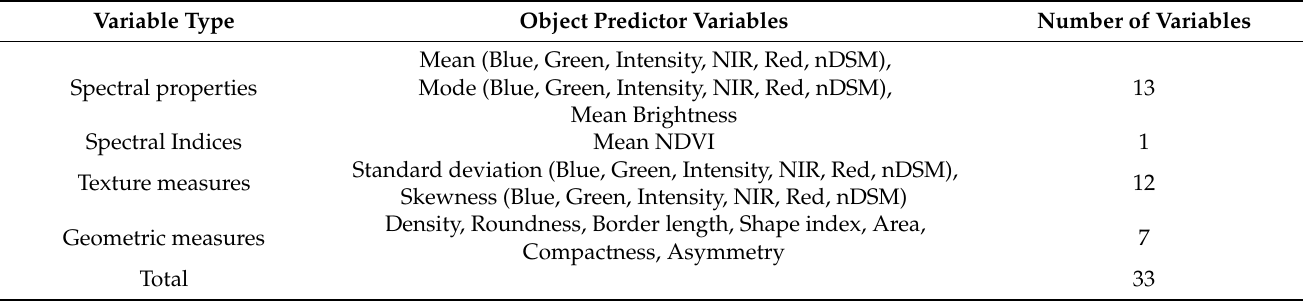
Table 2. Image-object predictor variables, consisting of spectral properties, spectral indices, texture measures, and geomet- ric